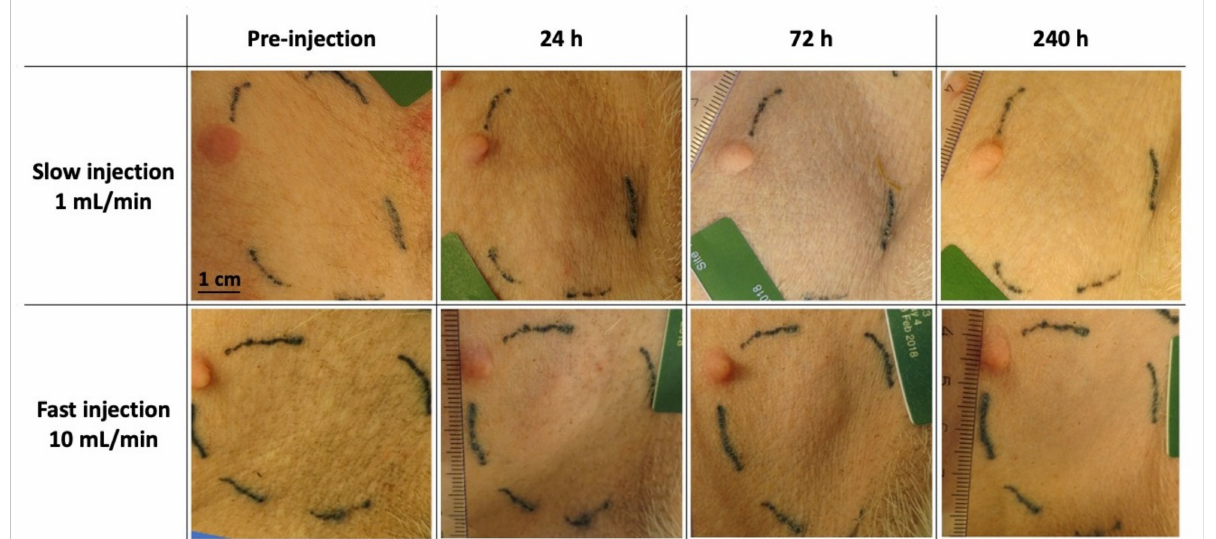
Figure 1. Macroscopic loco-regional tolerance assessment. Representative images of injection sites from 1 mL treated group along the study.